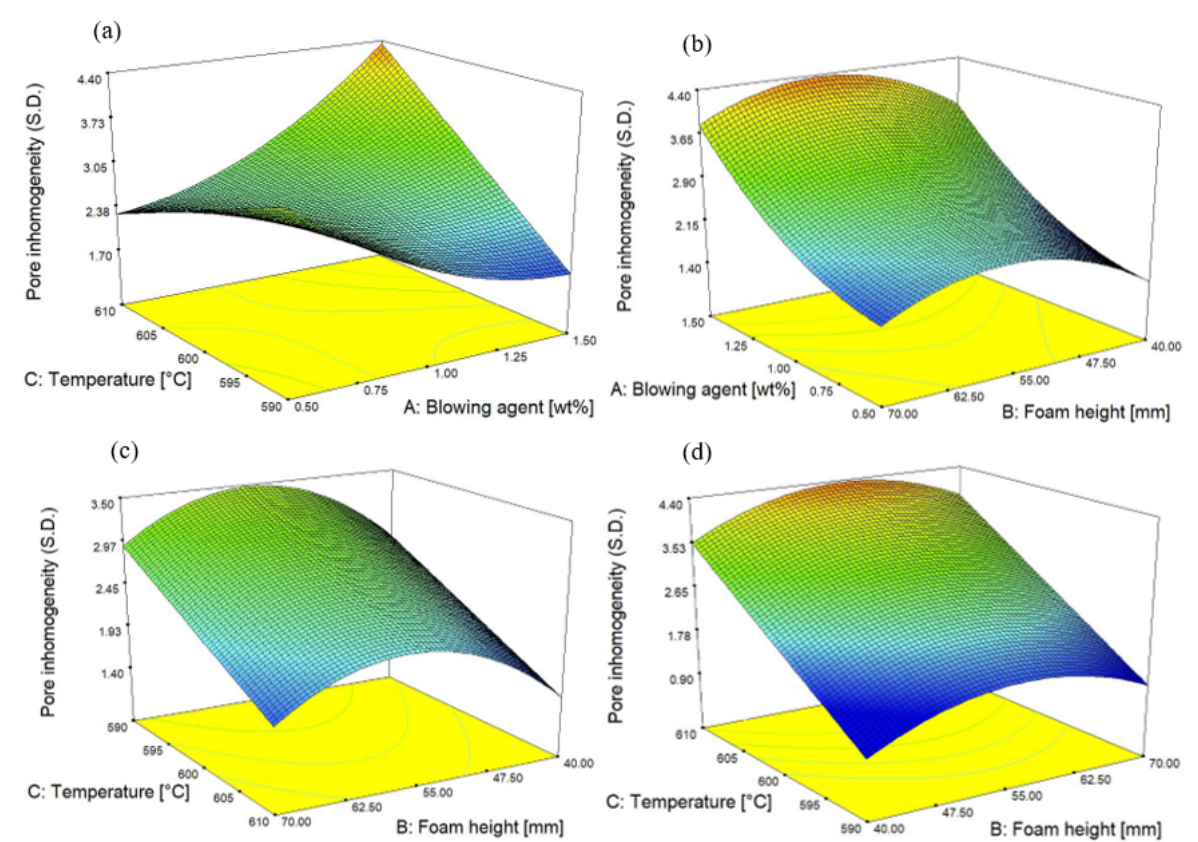
Figure 9. ( a ) Influence of foam height and temperature on foam pore inhomogeneity for a constant foaming height at 55 mm. ( b ) Influence of blowing agent (wt%) and foam height on foam pores inhomogeneity for the constant foaming temperature of 610 °C. ( c , d ) Influence of the foaming tem- perature and foam height for constant (wt%) of blowing agent of 0.5 and 1.5, respectively.